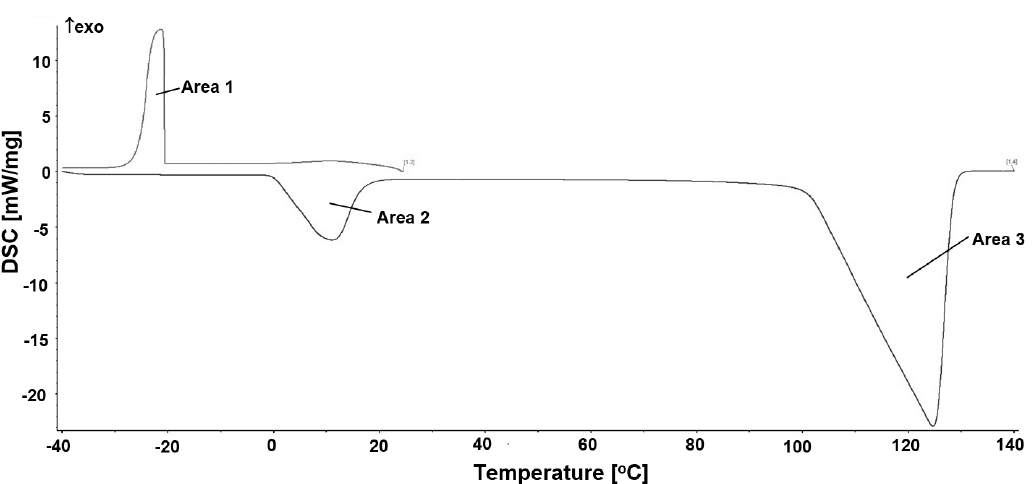
Figure 5. The typical course of the Differential Scanning Calorimetry (DSC) experiment shown for deionized water stored in the air. Table 3. Results of the DSC measurements for water treated under nitrogen